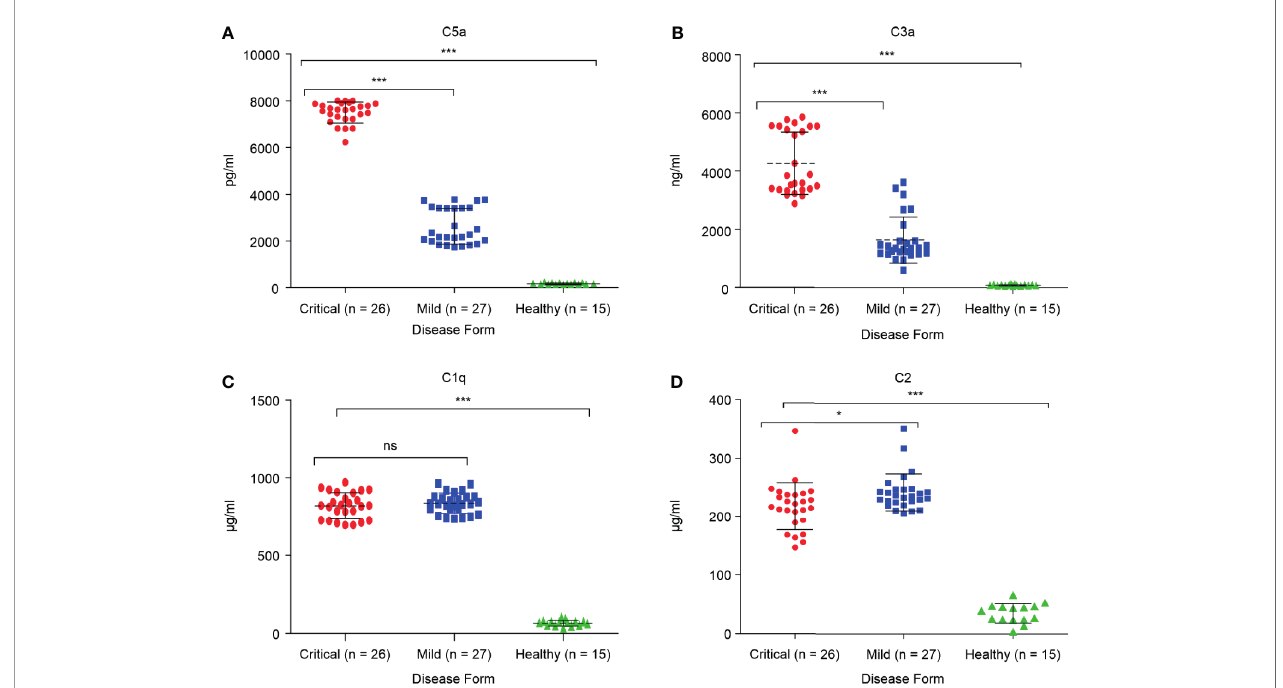
FIGURE 1 | Serum concentrations of the anaphylatoxins in critical and mild COVID-19 patients, and healthy controls. Concentrations of (A) complement fragment C5a; (B) complement fragment C3a; (C) complement fragment C1q; and (D) complement fragment C2 were measured using ELISA. ANOVA and Tukey ’ s multiple comparison test were used for statistical comparisons. * p <0.05, *** p < 0.001, and ns p >